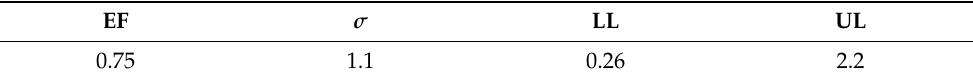
Table 6. Expected value, standard deviation, and back transformed mean and standard deviation for the log-normal distribution expressed in g/ton of crude oil processed for benzene.